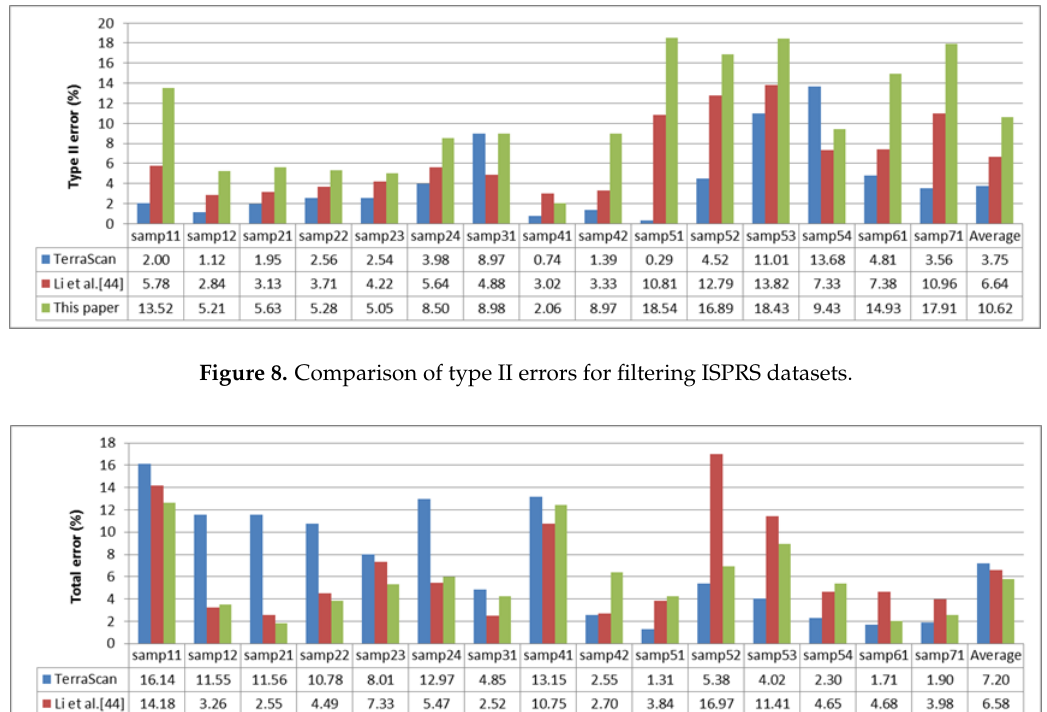
Figure 7. Comparison of type I errors for filtering the International Society for Photogrammetry and Remote Sensing (ISPRS) datasets.